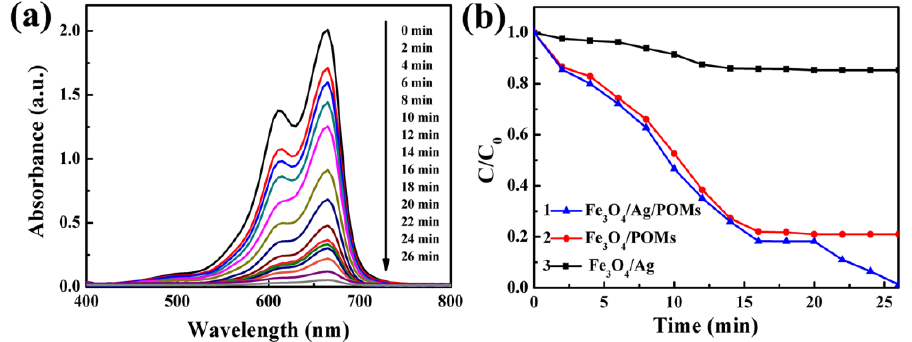
Figure 8. ( a ) Absorption spectra of methylene blue (MB) in the presence of Fe 3 O 4 /Ag/POMs nanocomposites, ( b ) removal of MB under irradiation of visible light after reaching adsorption equilibrium.